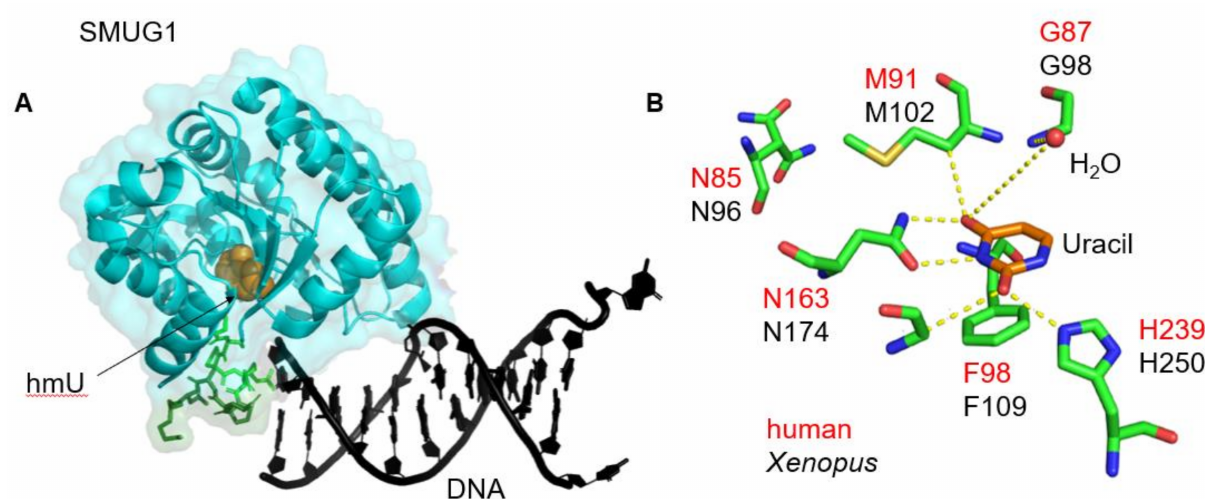
Figure 2. Structure of SMUG1 highlighting the role of the wedge domain in catalysis. Crystal structure of Xenopus SMUG1 ( A ) The glycosylase (blue) bound to DNA (black) containing an abasic site with the damage recognition wedge (loop, light green; helix, dark green) with the free 5-hmdU (orange), PDB: 1OE6. ( B ) Key active site residues of SMUG1 (PDB: 1OE5), with Xenopus (black) and human (red) numberings; adapted from [8] with